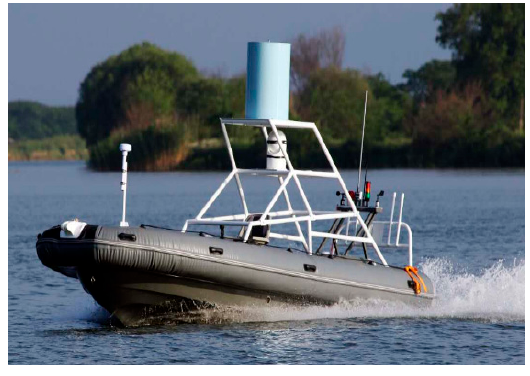
Figure 27. Jellyfish .